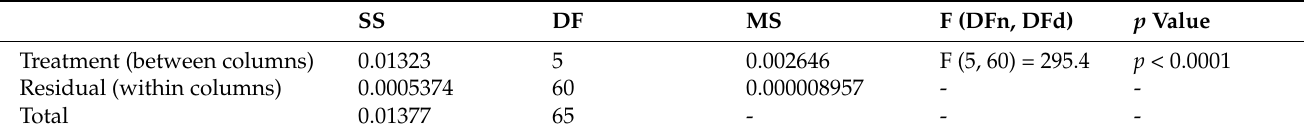
Table 8. Compared and proposed classifiers test results for ANOVA.